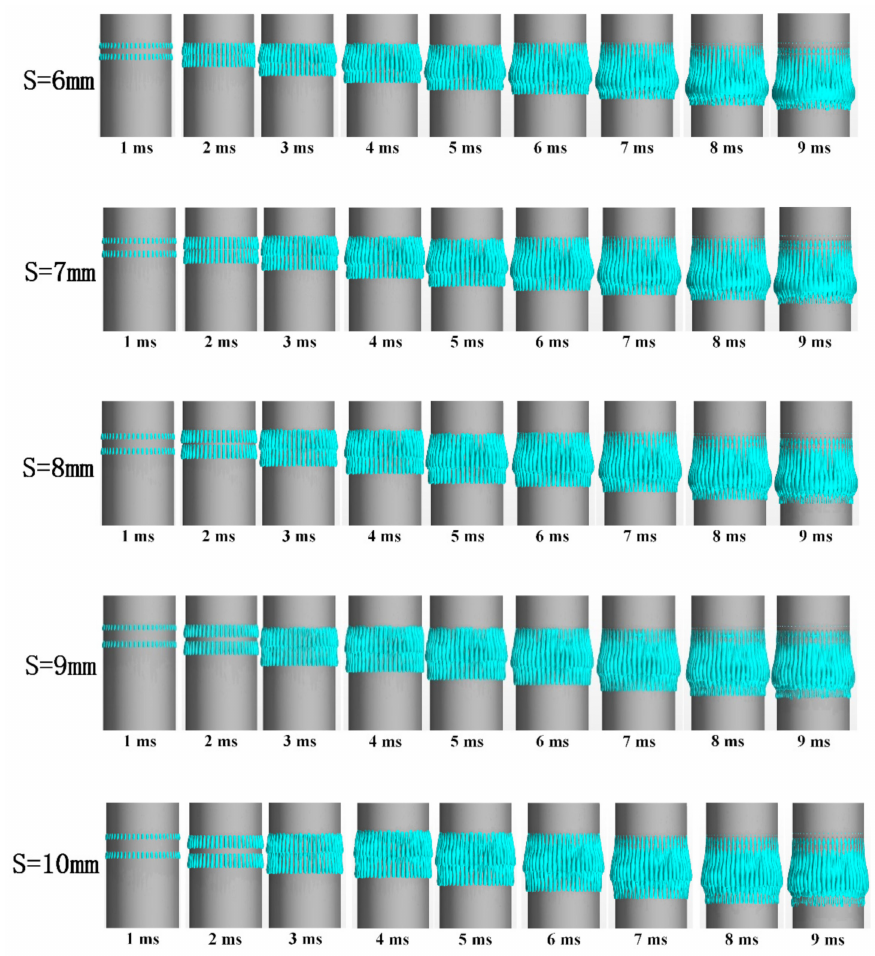
Figure 17. Three-dimensional shape of the air film at different